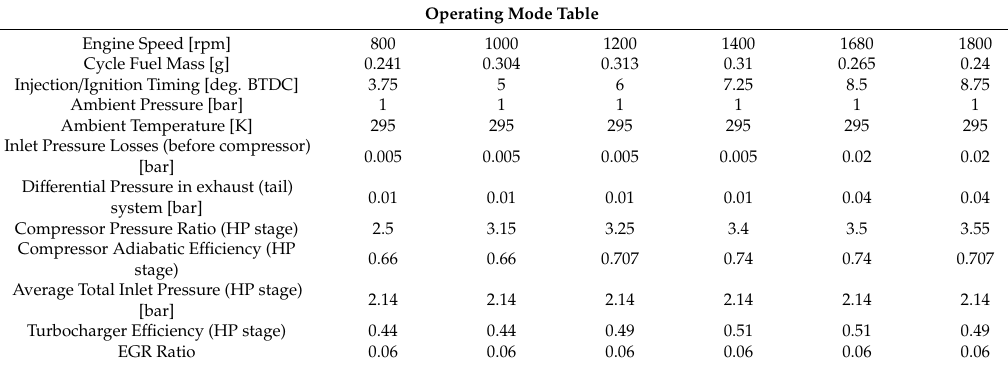
Figure 1. Graph ( a ) represents the SFC and graph ( b ) represents the engine power of the RM. Both graphs consist of the results from the 1D scanning function at 1680 rpm. Based on these graphs, the start of injection (SOI) degrees were selected and registered in the operating mode in Table 2. Table 2. Operating mode table of the reference model.